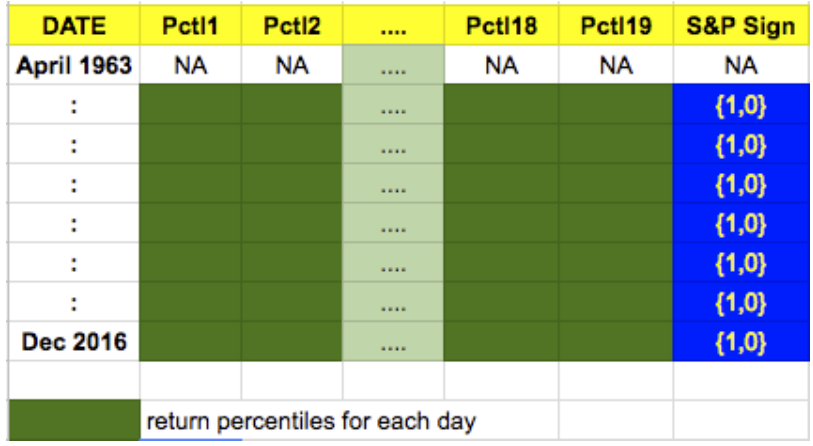
Figure 3. Depiction of the returns for each day in percentiles, where 500 stocks returns are reduced to 19 values for the following percentiles: 1, 2, 3, 5, 10, 15, 20, 30, 40, 50, 60, 70, 80, 85, 90, 95, 97, 98, and 99. Note that for the index, the values remain as the sign of movement, where the value is 1 if the index moved up, else it is 0, just as shown in Figure 2.